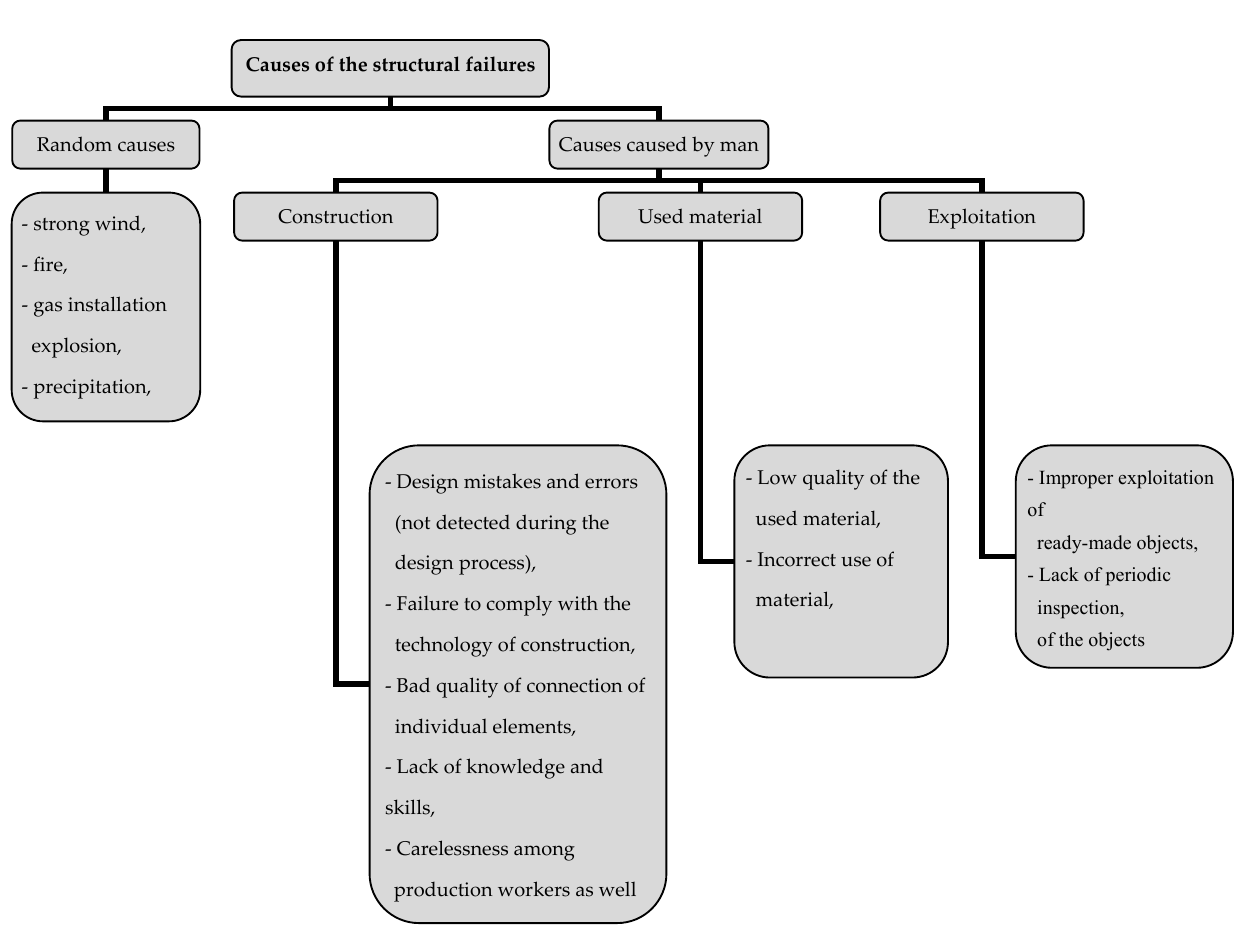
Figure 4. Classification of structural failures (own study).